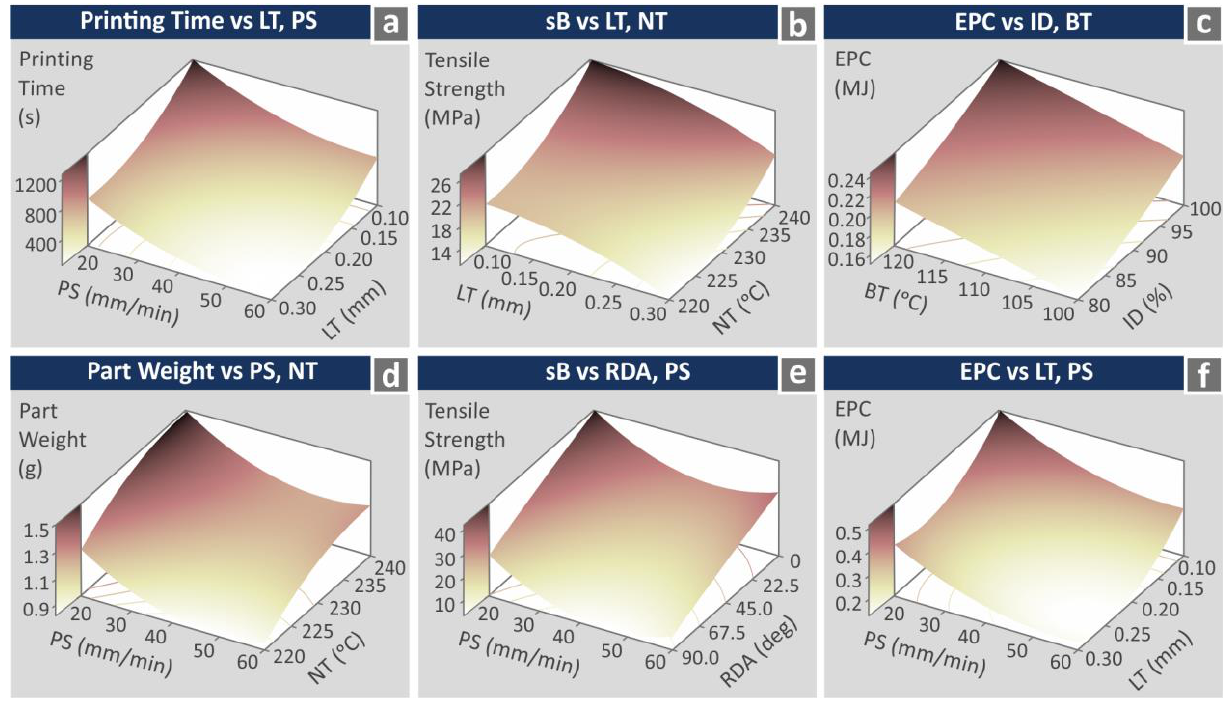
Figure 12. Pareto and experimental vs. calculated charts: ( a ) tensile strength (MPa), and ( b ) EPC (MJ).